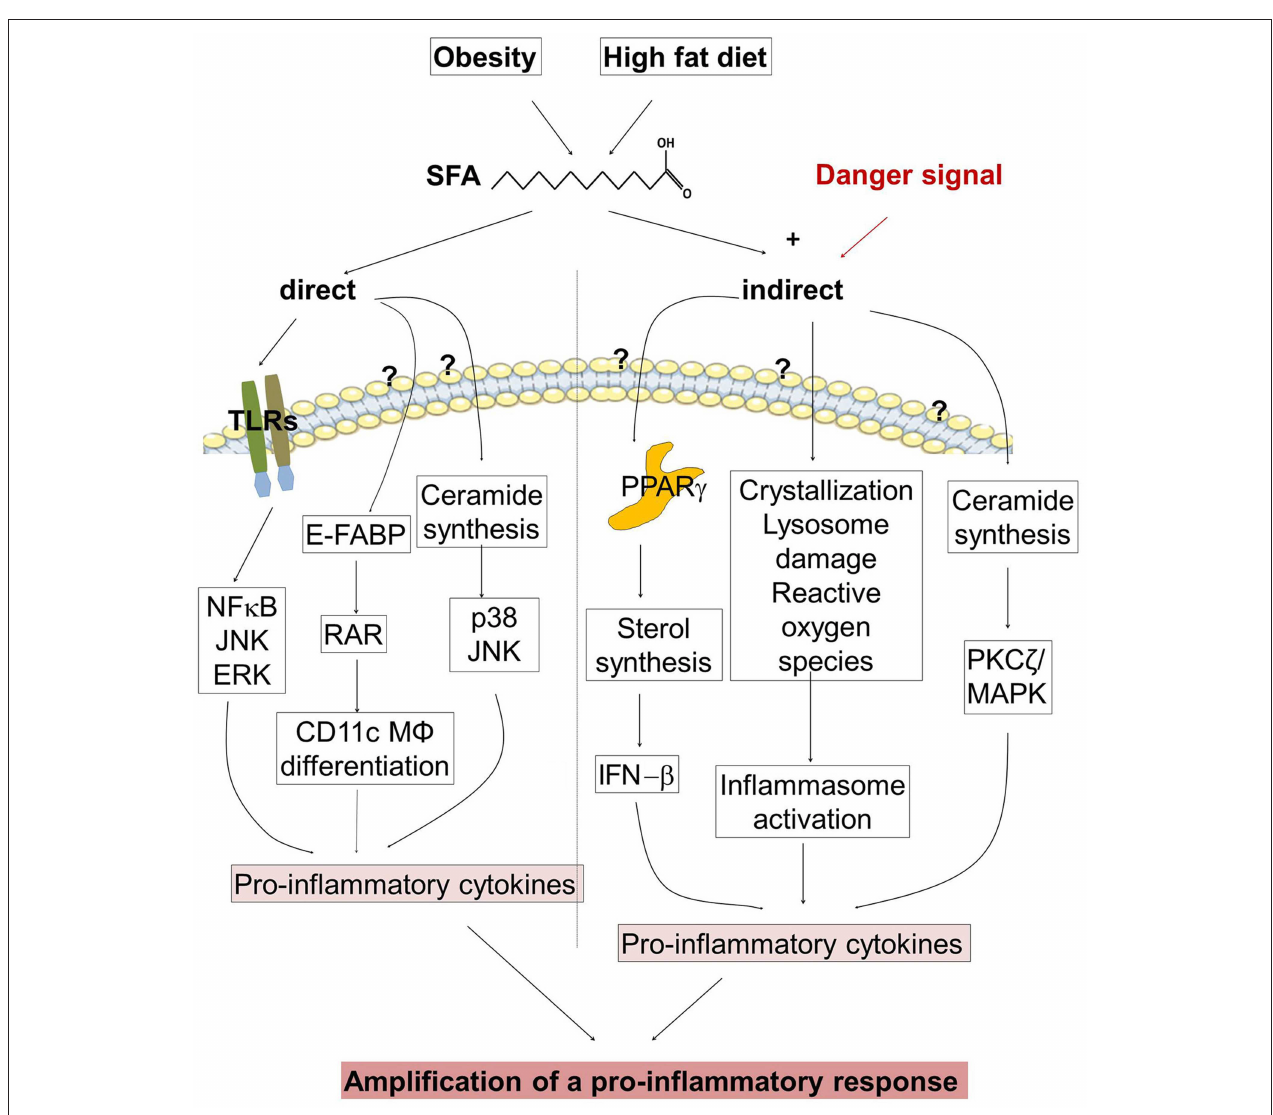
FIGURE 2 | Regulation of the pro-inflammatory response in psoriasis. ( Left half of the figure) Obesity and high fat diet (HFD) increase the concentration of saturated fatty acids (SFAs). SFAs are able to stimulate directly the expression of pro-inflammatory cytokines. SFAs activate toll-like receptors (TLR), and bind to cytoplasmic epidermal fatty acid binding proteins (E-FABPs) activating retinoid acid receptor (RAR) and stimulate the differentiation of CD11c + macrophages (MØ). An Increase of SFAs modulates ceramide synthesis. ( Right half of the figure) SFAs amplify the pro-inflammatory response in the presence of a danger signal. SFAs stimulate the expression of pro-inflammatory cytokines via binding to PPARs, by inflammasome activation, and by modulation of ceramide synthesis. Until now it is not clear which receptors are involved in FFA binding, translocation into the cell and subsequent pro-inflammatory activity.